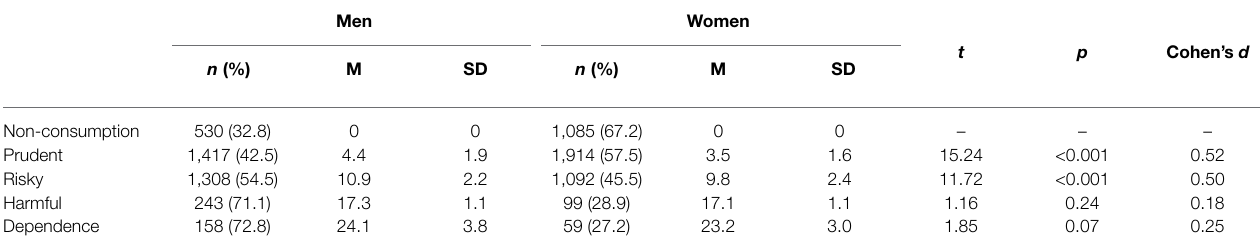
TABLE 2 | Gender differences on alcohol consumption levels (AUDIT scores).